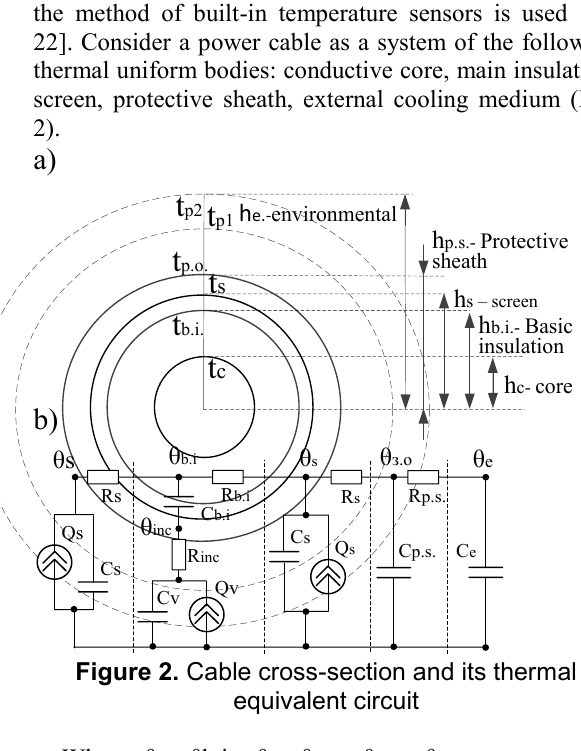
Figure 2. Cable cross-section and its thermal equivalent